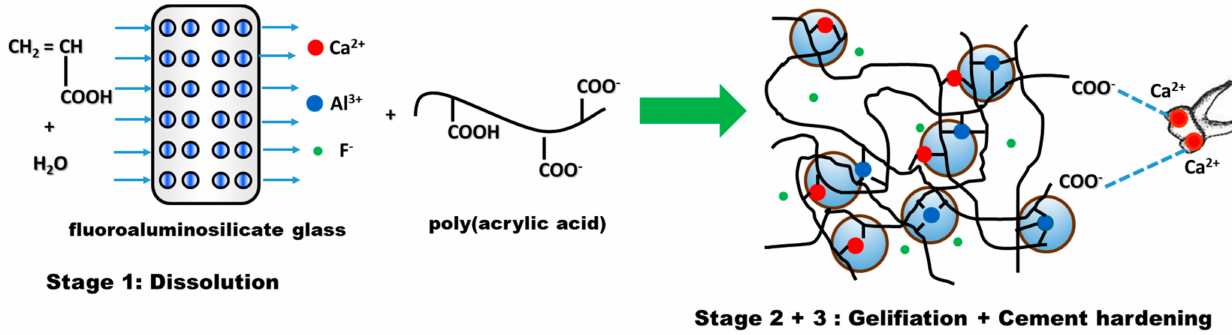
Figure 5. Setting reaction of glass ionomer